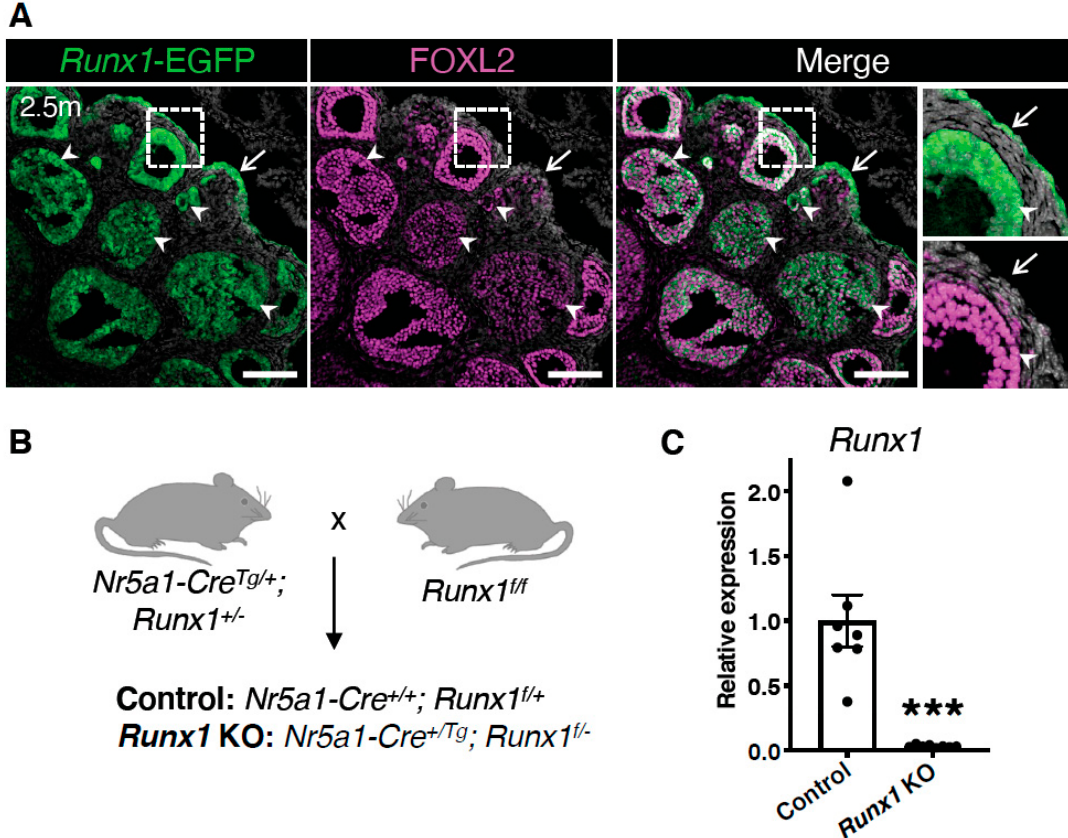
Figure 1. Runx1 expression in granulosa cells and surface epithelium of adult mouse ovaries. ( A ) Detection of Runx1 -EGFP and FOXL2 by immunofluorescence in mouse ovaries at 2.5 months of age. Grey color represents nuclei labelled with 4 (cid:48) ,6-diamidino-2-phenylindole (DAPI). Arrows point to ovarian surface epithelium. Arrowheads point to granulosa cells. The far-right panels are higher magnifications of outlined areas. Scale bars: 250 µ m. ( B ) Mating strategy for the generation of the control and Runx1 conditional KO mice. All Nr5a1 + somatic cells of the ovary were targeted to create a conditional knockout. ( C ) Relative mRNA expression of Runx1 in control and Runx1 KO ovaries at 4.5 months (control: n = 7; KO: n = 8). Values are presented as mean ± SEM; Student t-test, *** p <